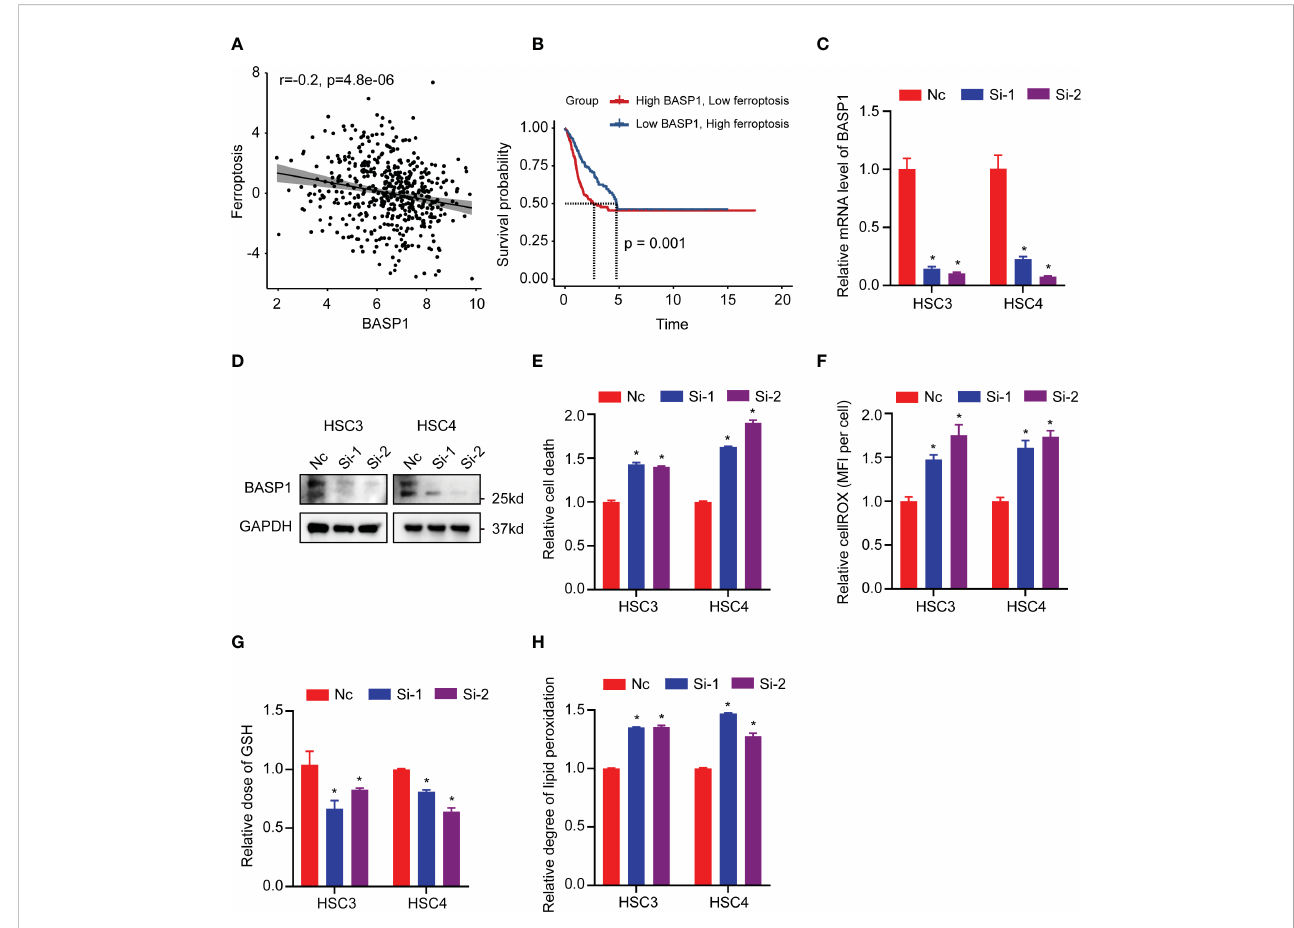
FIGURE 7 Relationship between BASP1 and ferroptosis. (A) The correlation between ferroptosis score and BASP1 expression. (B) Survival curves of ferroptosis scores in BASP1 high group and BASP1 low group. (C, D) The mRNA (C) and protein (D) levels of BASP1 in HSC3 and HSC4 cells transfected with BASP1 siRNAs. (E – H) Relative LDH (E) , cROS (F) , GSH (G) and lipid peroxidation (H) of HSC3 and HSC4 cells transfected with BASP1 siRNAs. * p <